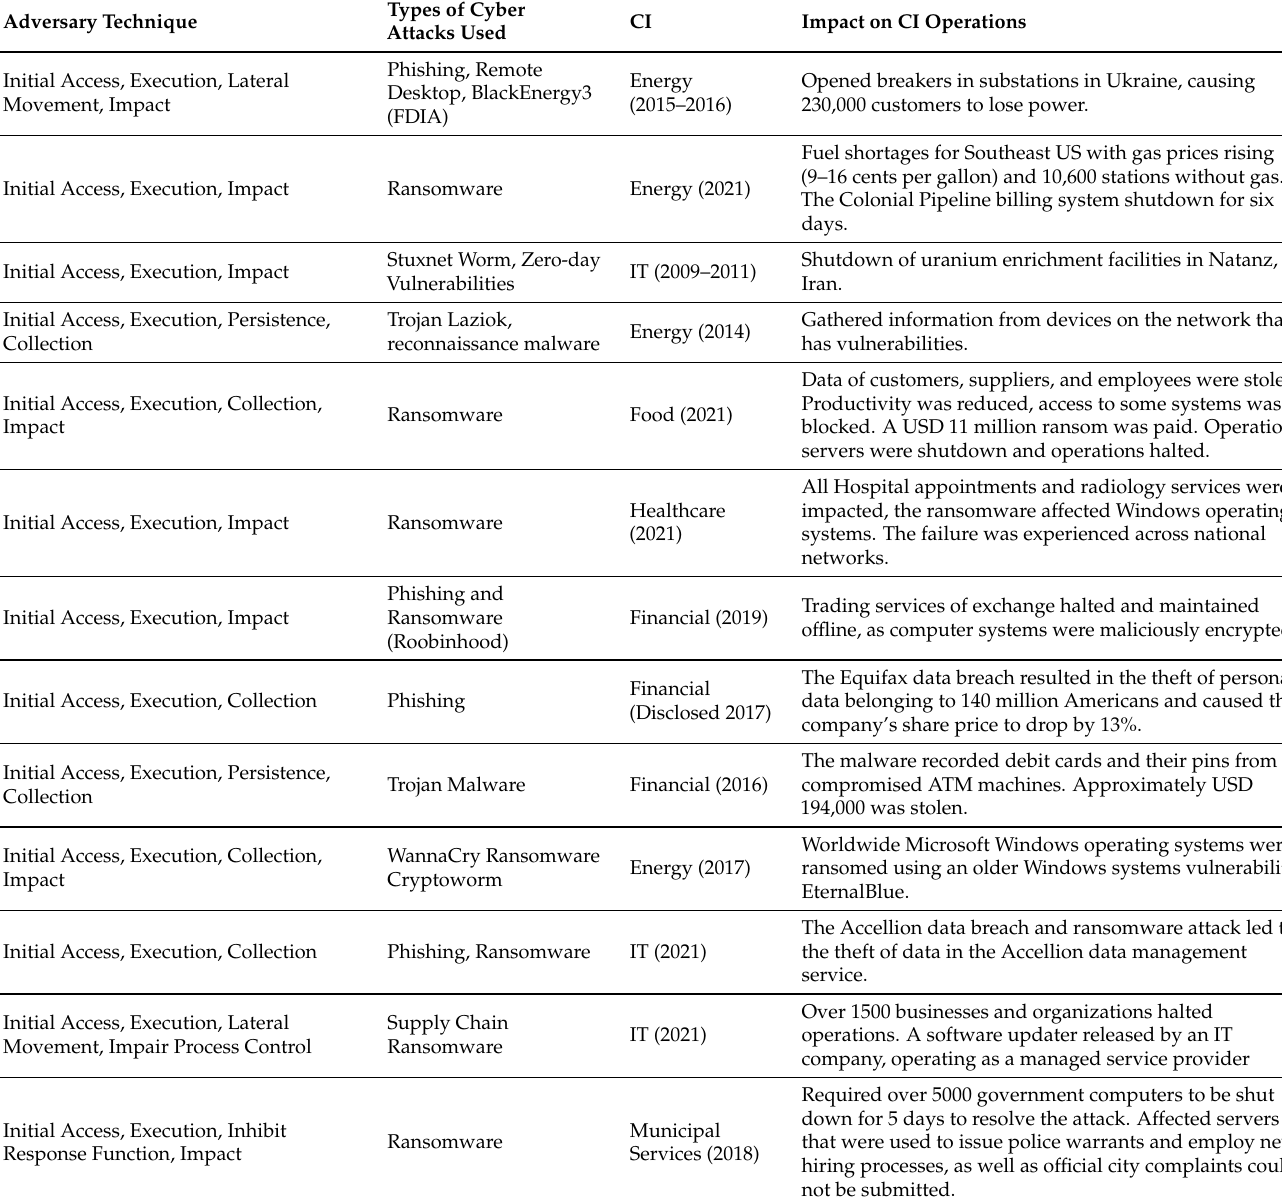
Table 1. Abridged list of significant cyber attacks in recent